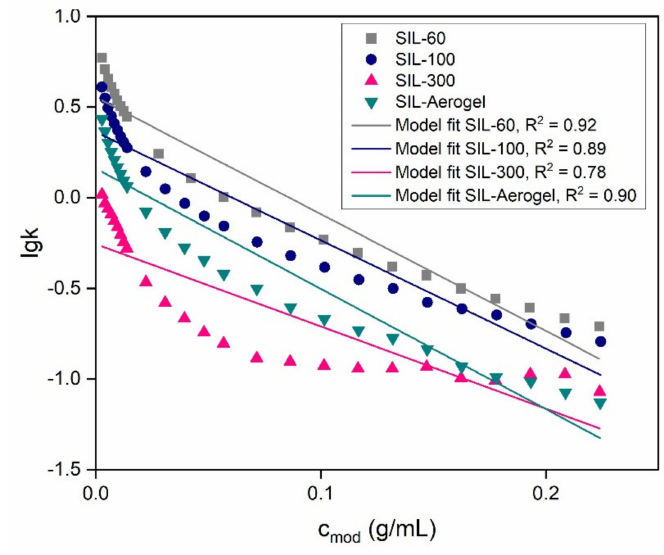
Figure 2. Retention factors of phenol on different silicas and model fittings according to DIM-Lin-kc.